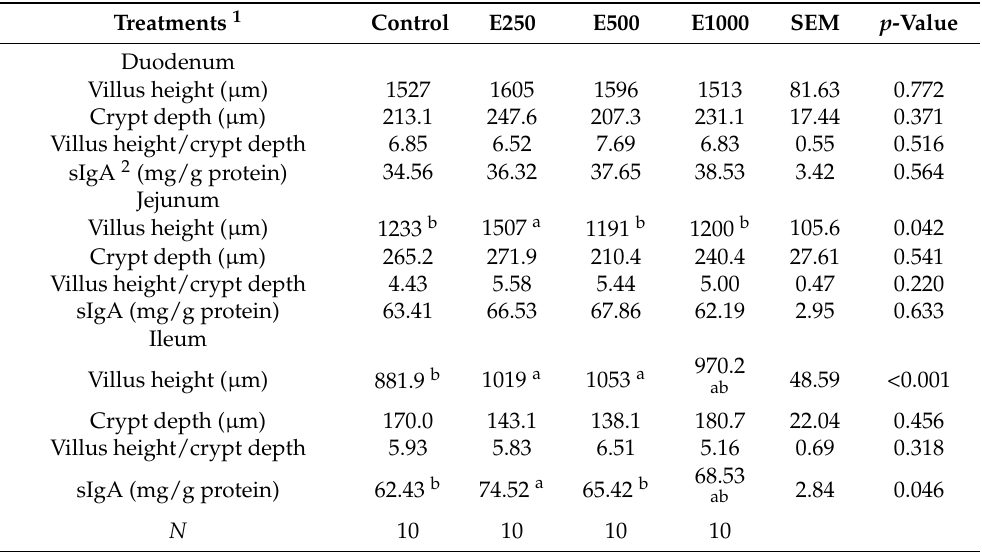
Table 4. Effect of glucose oxidase addition on the intestinal morphology of broilers at 42 days of